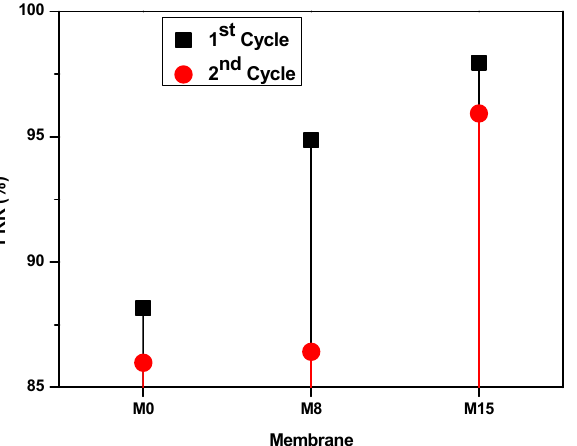
Figure 8. FRR percentages results of the prepared membranes during the first two cycles. Experimental error below than 5%.